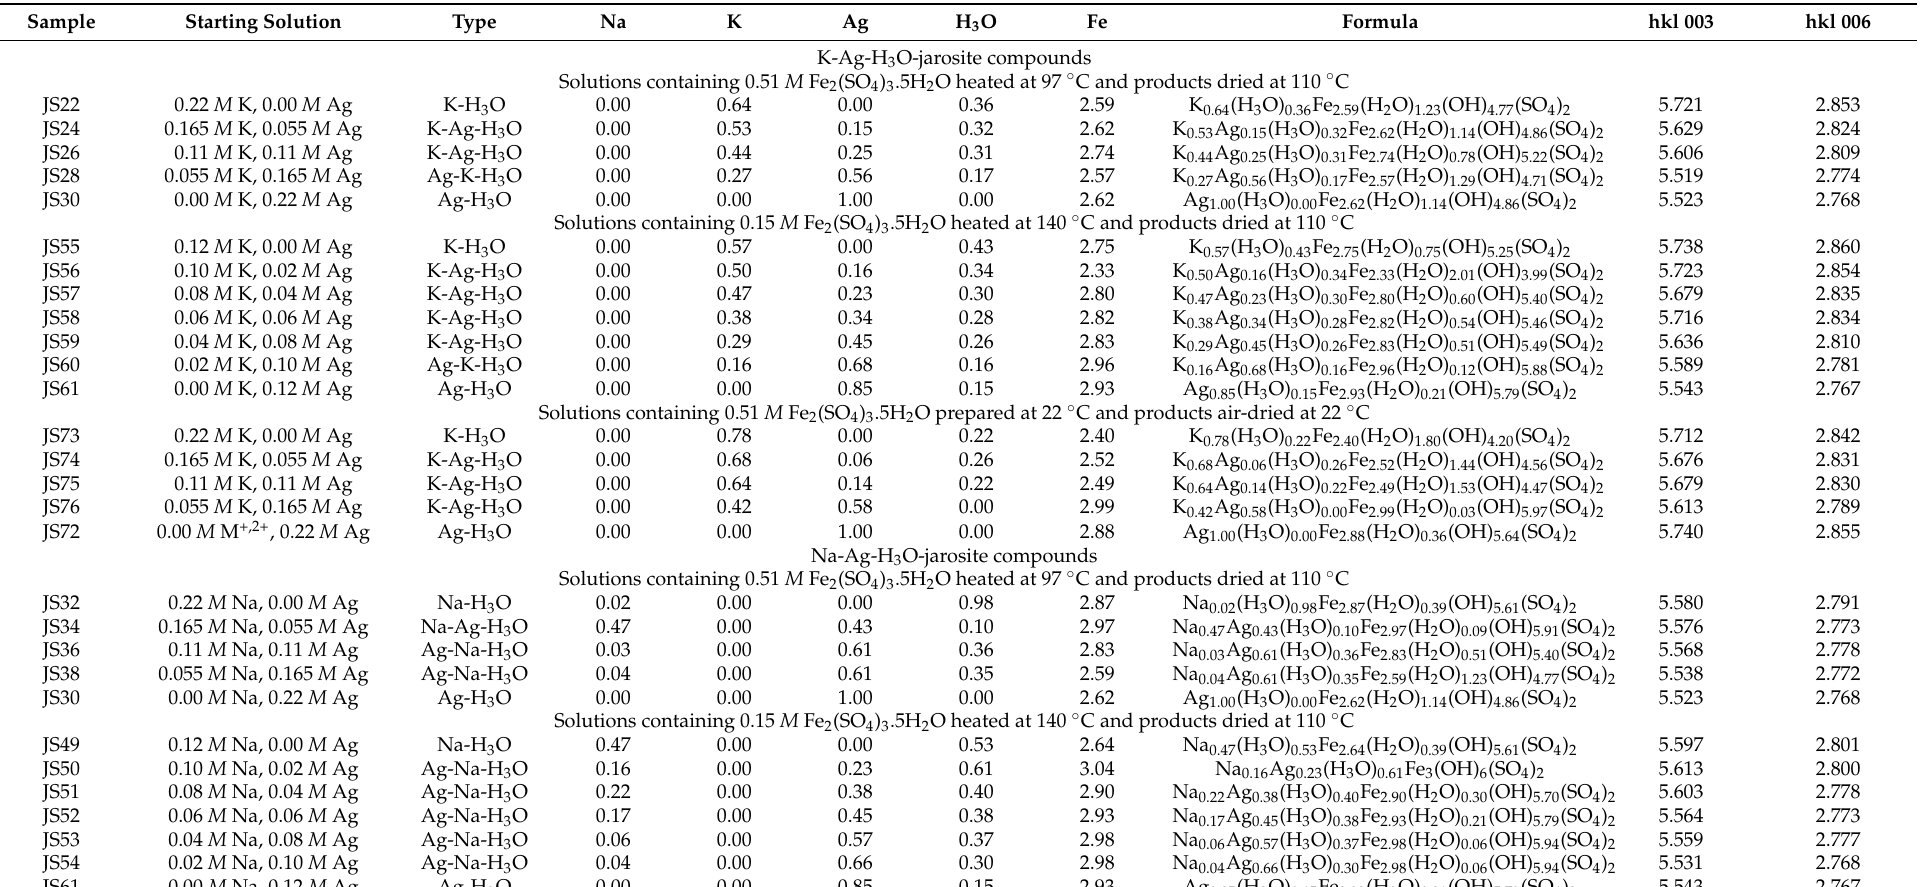
Table 2. Starting solutions, site occupancy and XRD peaks of synthetic K-Ag-H 3 O and Na-Ag-H 3 O jarosite compounds. Peak shifts should be most pronounced of c parameters, which are indicated by hkl indices of 003 and 006